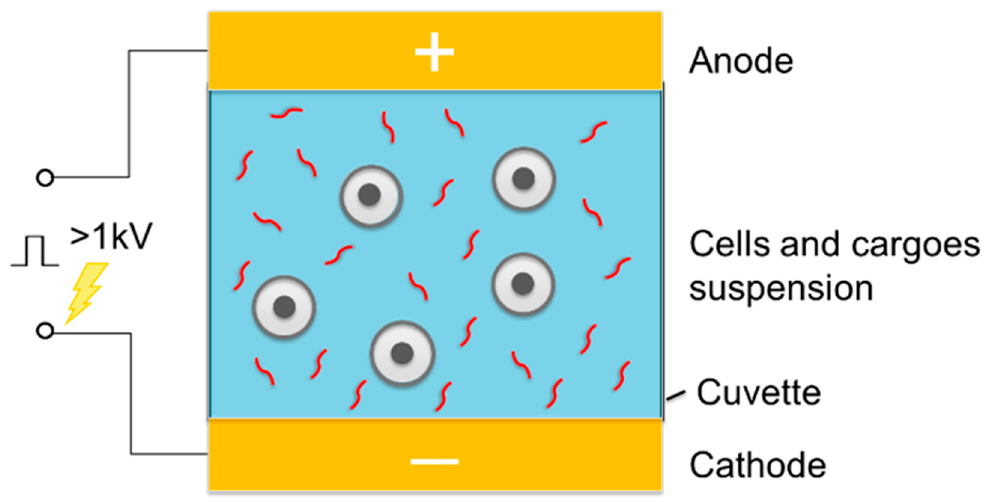
Figure 5. Schematic of electroporation system for cell suspensions.